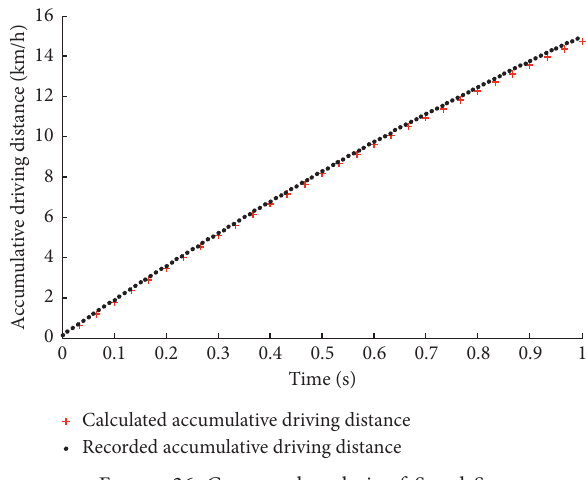
Figure 26: Compared analysis of S and S